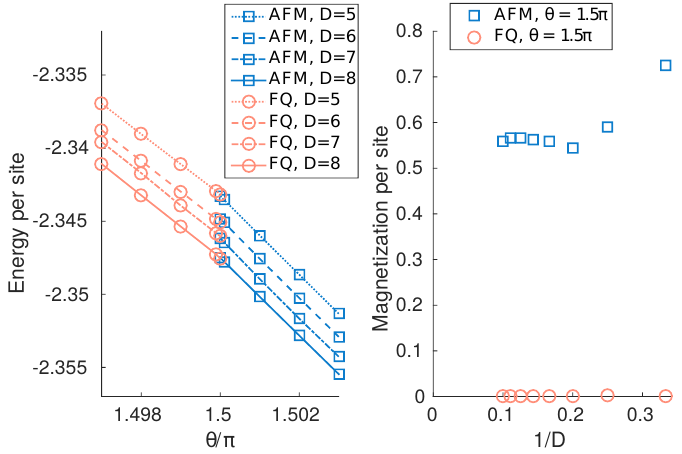
Figure 14: Energy per site as a function of θ for D = 5,...,8 (left) and magnetization per site exactly at the phase transition at θ = 3 π/ 2 for D = 3,4,...,10 (right) for the